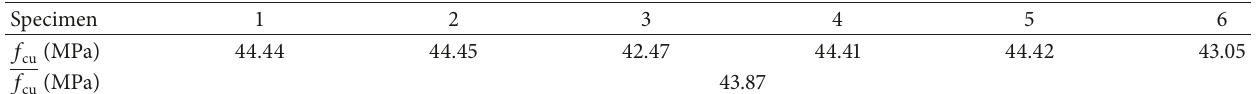
Figure 7: Sensors used in the shaking table test. Table 1: Concrete compressive cube strength of frame structure.